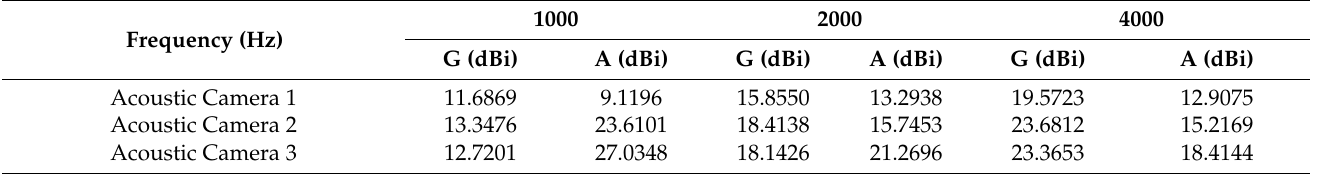
Table 7. Signal gains and side lobe attenuation of each acoustic camera prototype.